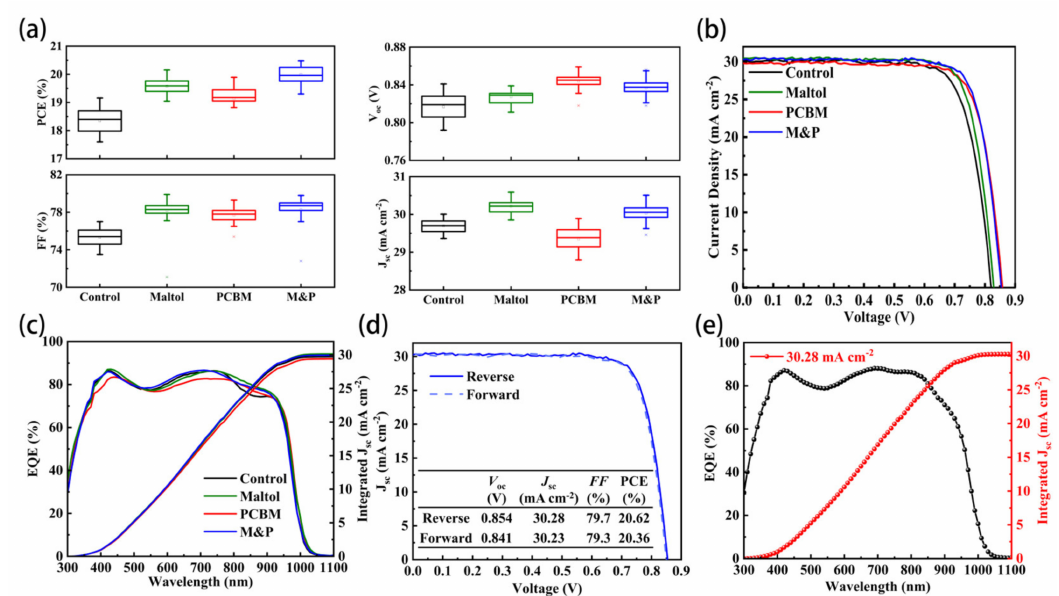
Figure 2. Photovoltaic performance of the four kinds of PSCs. ( a ) Statistical results of V oc , J sc , FF and PCE of the four different PSCs, ( b ) J-V curves under reverse scan and ( c ) EQE plots of PSCs with different treatments, ( d ) J-V curves of the champion device under reverse and forward scan, and ( e ) EQE curve of the champion device.